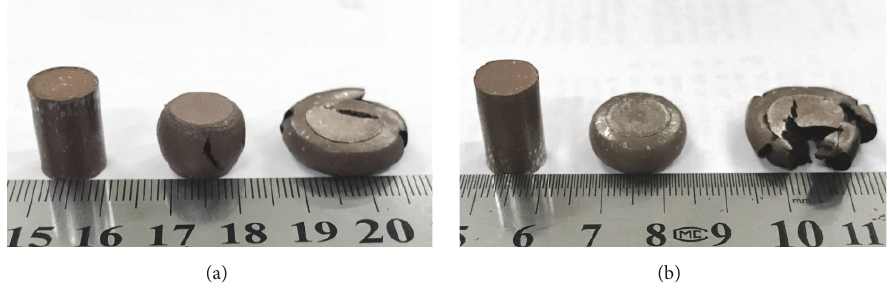
Figure 2: Samples before and after quasi-static compression. (a) Type A specimen and (b) type B specimen.